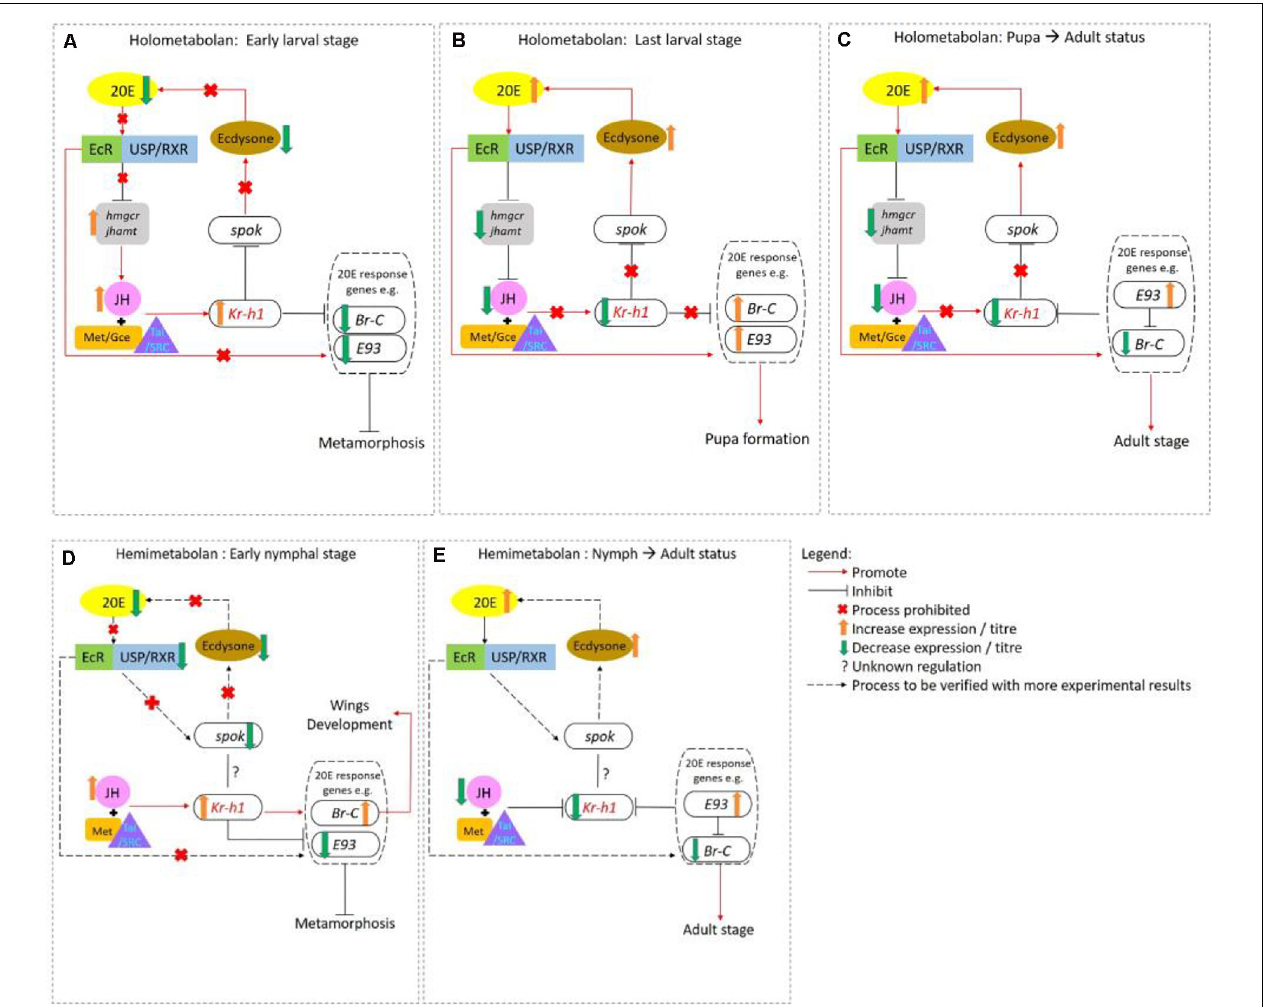
FIGURE 2 | Interaction of sesquiterpenoid juvenile hormone (JH) and ecdysteroid during metamorphosis in holometabolans (A–C) and hemimetabolans (D,E) . (A) In early larval stages of holometabolous insects, JH-Met/Tai receptor complex activates the transcription of primary JH-early responsive gene Kr-h1 which prevents immature larvae from precocious larval development by inhibiting Br-C , E93, and Spok expression. (B) When JH levels drastically drop in the last larval stage, 20E acts through EcR/USP to activate the transcription of 20E-early responsive genes such as Br-C , E93, E74 , E75 , Ftz - f1 and initiate larval-pupal transition. (C) At the end of the pupal stage, the Br-C levels decline again which upregulates the expression of E93 that drives the pupa-adult transition. In hemimetabolous insect, JH titer remains high from hatching until the last nymphal stage. (D) During the early nymphal, high Kr-h1 expression level is maintained by JH which inhibits metamorphosis by repressing E93 expression. (E) In the last nymphal stage, the JH titers fall followed by the Kr-h1 expression level. For details, please refer to main text and Truman,